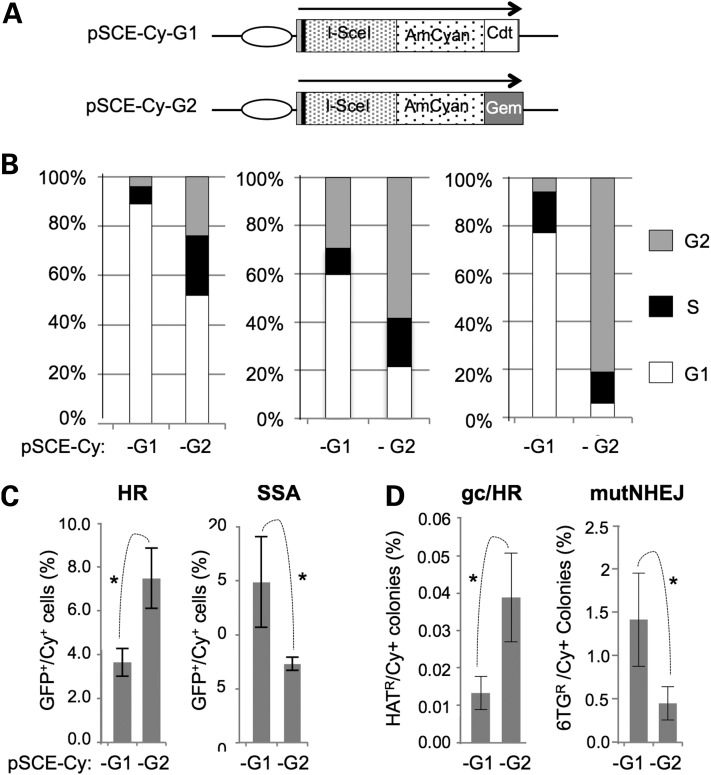
Development and use of cell cycle-specific I-SceI. (A) Schematic representation of I-SceI expression plasmids. Ellipse, cytomegaloviral promoter; black bar, haemagglutinin tag. (B) Cell cycle profiles of cells lipofected with the indicated plasmids. Cells were HT1080-WT (left), HT1080-AS5 (Supplementary Material, Table S1; centre) and HeLa (right). (C) Differential effects of cell cycle-restricted I-SceI on reporters for HR and SSA. The indicated plasmids were transfected into cells (HT-DR-GFP-8 or HT-SSA-GFP; Supplementary Material, Table S1) carrying GFP-based reporters for a HR or SSA. The percentage of AmCyan+ cells that were GFP+ is shown. (D) Differential effects of cell cycle-restricted I-SceI on mutNHEJ and gene correction at the HPRT locus. Assays based on clone 5.2.1 (mutNHEJ) or clone 3B (gene correction) were used with the indicated I-SceI expression plasmids. Results were normalized to the amount of AmCyan expression. Mean and SDs for three or more assays are presented with significant differences marked (*P < 0.05; Student's t-test).